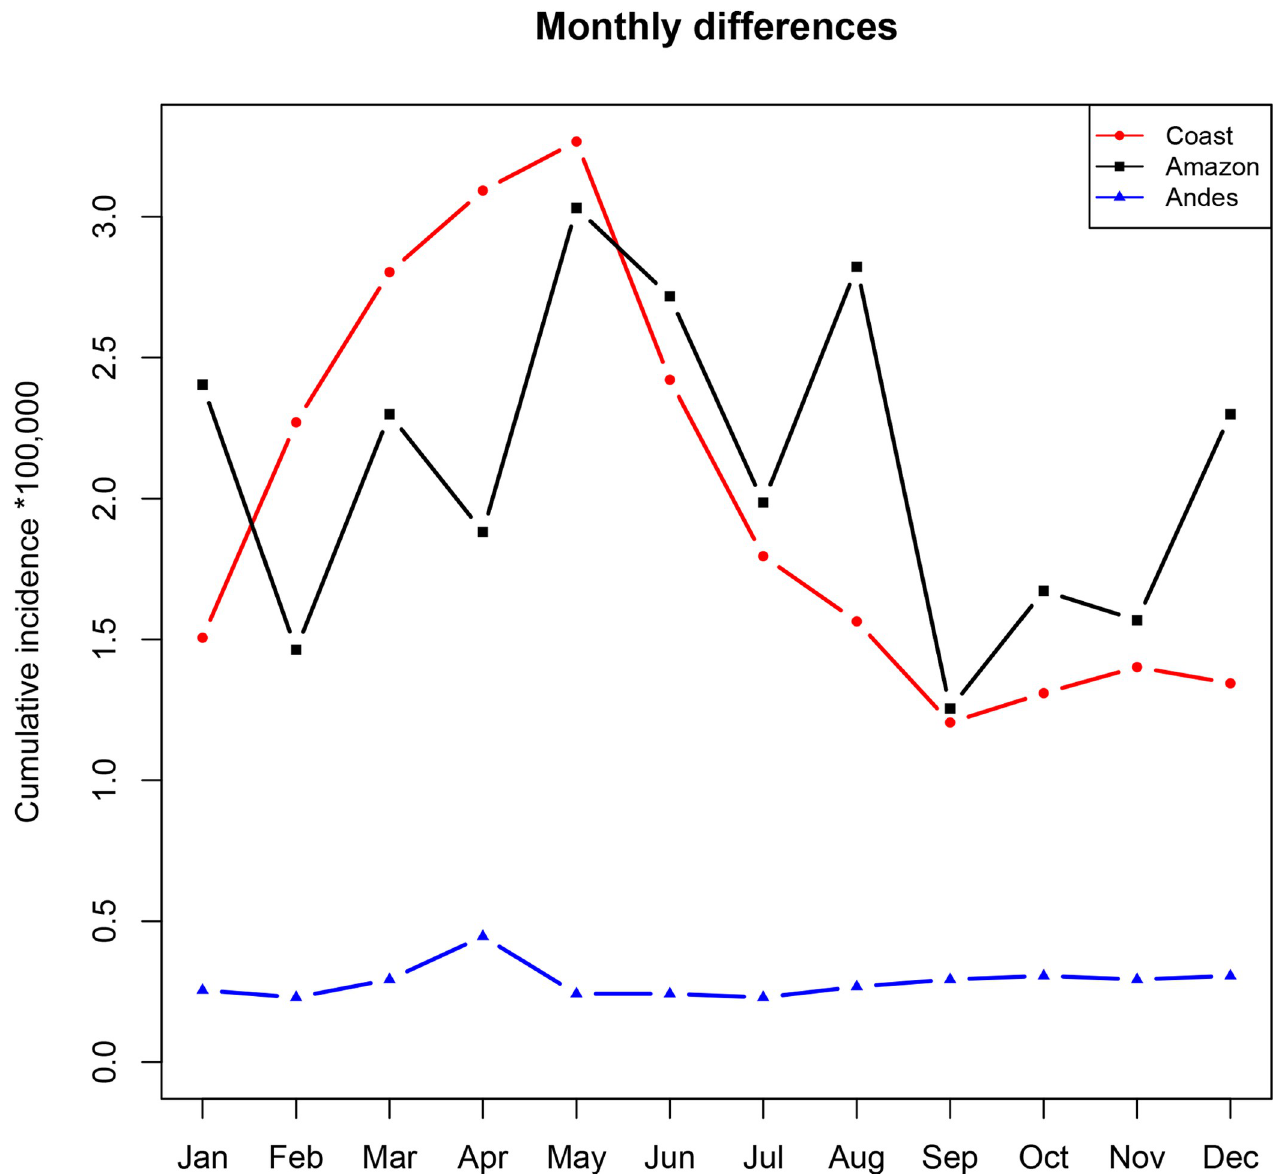
Fig 7. Hospitalized leptospirosis by the month in the three continental geoclimatic regions (2000–2020). In the figure, the cumulative incidence per 100,000 is plotted on the ordinate as a function of the months of the year indicated on the abscissa for the Coast (red circles), Amazon (black squares), and Andes (blue triangles) ecoregions. An increase in cases occurred for the Coast from January to June. Cases throughout the Amazon increased and decreased during the year. In contrast, the number of hospitalizations in the Andes (blue) was relatively constant over time except for a peak of hospitalizations in April. The incidence was calculated from the total estimated population of Ecuador for 2020 as the denominator per 100,000